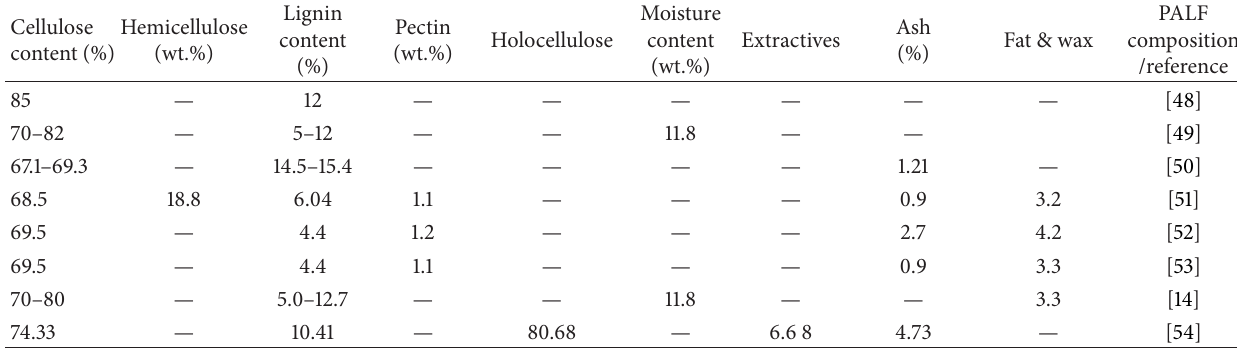
Table 6: Chemicals composition of PALF.